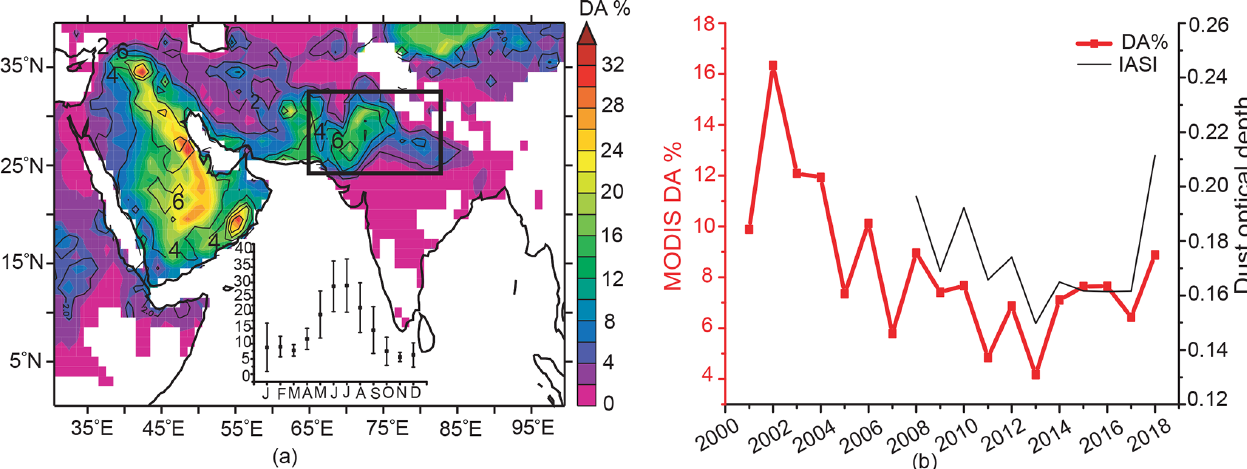
Figure 1. (a) Shading shows the spatial distribution of DA % averaged for 2001–2018, and contours are the standard deviations of DA % for the same period. The black rectangle indicates the dust belt in South Asia (24–32 ◦ N, 65–82 ◦ E) which is used for subsequent analysis. The monthly climatology and the standard deviation of DA % over the dust belt in South Asia are shown in the inset using black squares and vertical bars, respectively. (b) Time series of the MODIS-derived DA % and IASI-retrieved annual dust optical depth over the dust belt in South